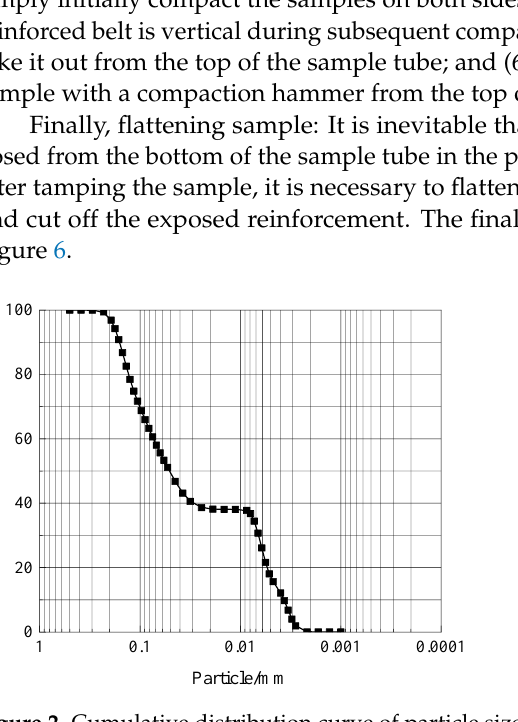
Figure 2. Cumulative distribution curve of particle size of the tailings sample.